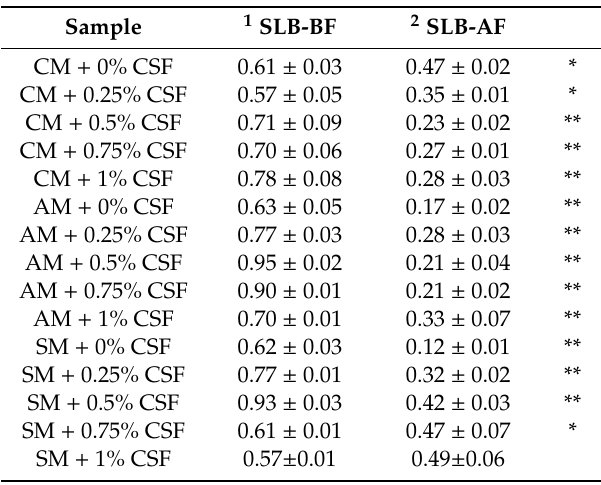
Table 2. Solid–liquid balance (SLB) before and after fermentation process. The results are the mean of three experiments ± standard deviation. (* p value < 0.05; ** p value < 0.001).